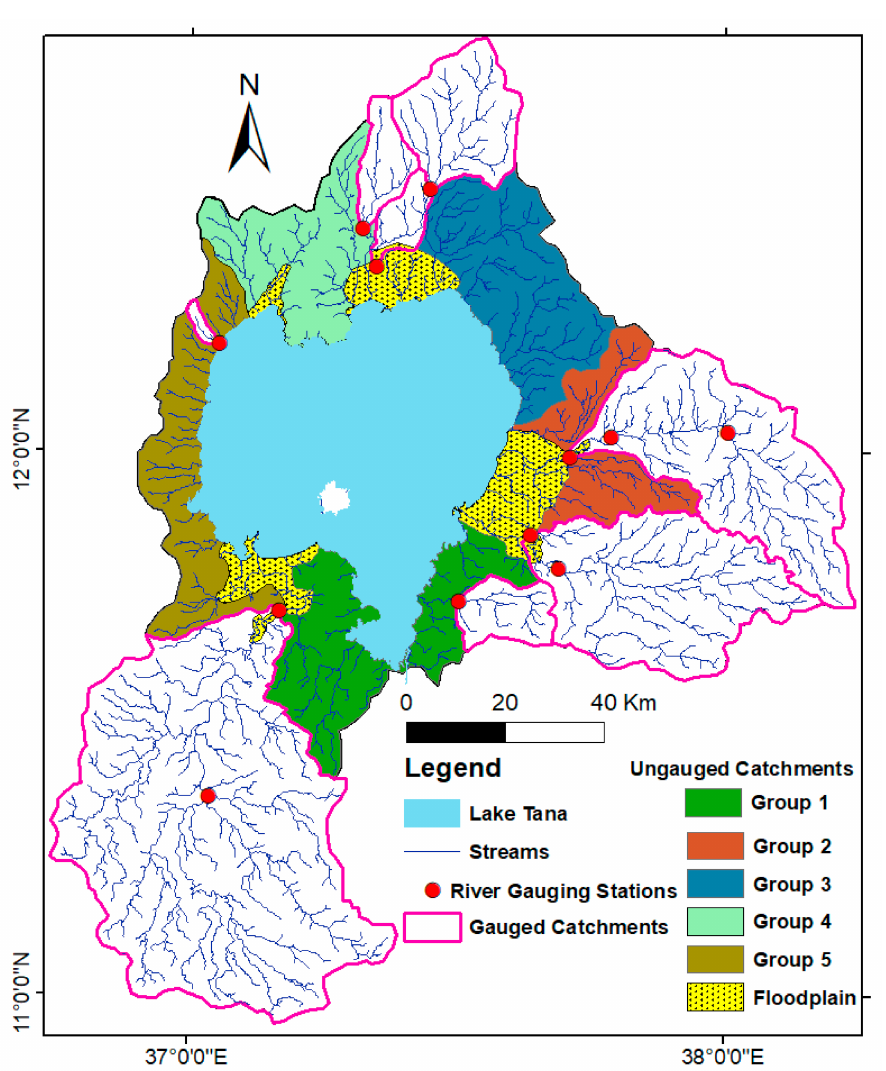
Figure 6. Map of Lake Tana Basin with the location of the floodplain, gauged and ungauged catchments modified after Dessie et al. [12]. According to Dessie et al. [12], runoff from the groups of ungauged catchments was predicted based on calibrated model parameters of observed runoff data from Gelda for Group 1, from Rib for Group 2, from Megech for Group 3, from Dirma for Group 4, and Dirma for Group 5. The selection of hydrological areas to transfer hydrological parameters is based on similarities in hydro-physical